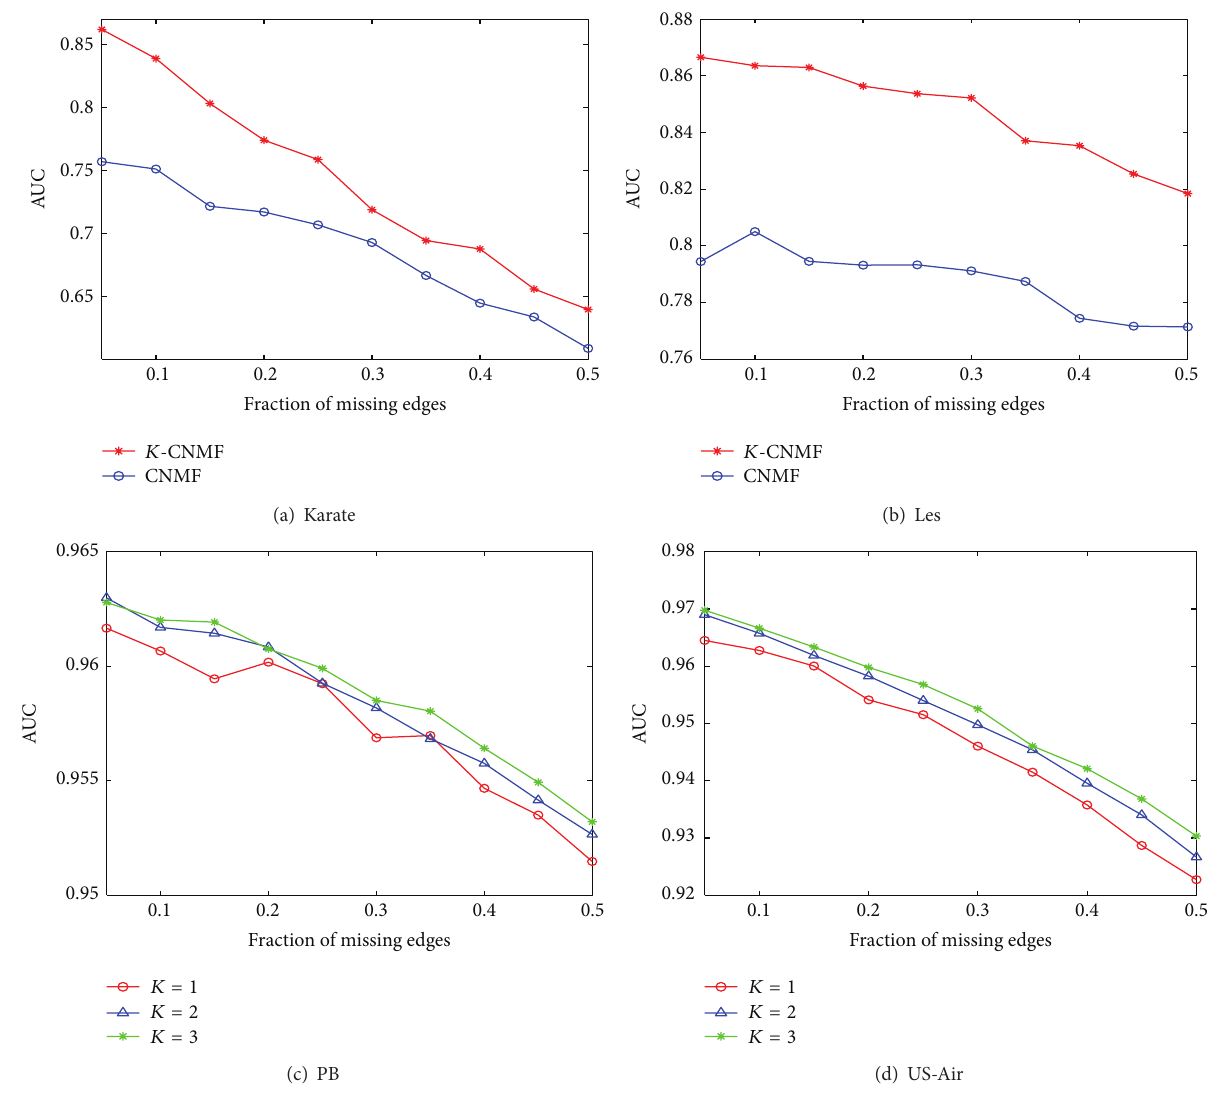
Figure 2: Comparison of 𝐾 -CNMF for different 𝐾